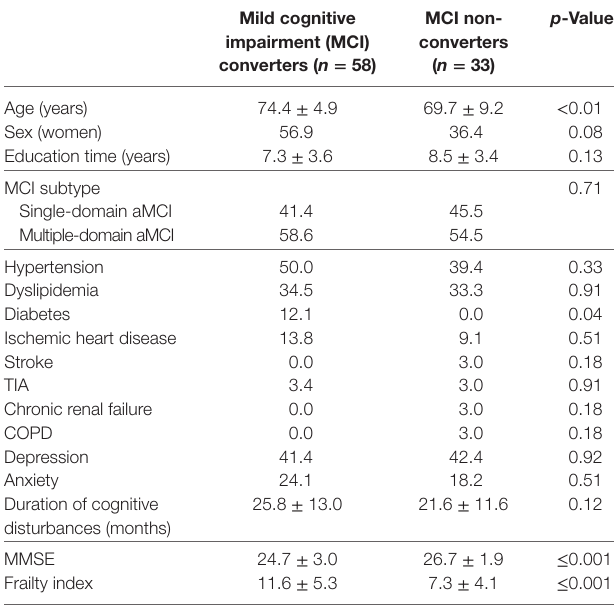
TaBle 2 | Baseline sociodemographic and clinical characteristics of the sample according to MCI